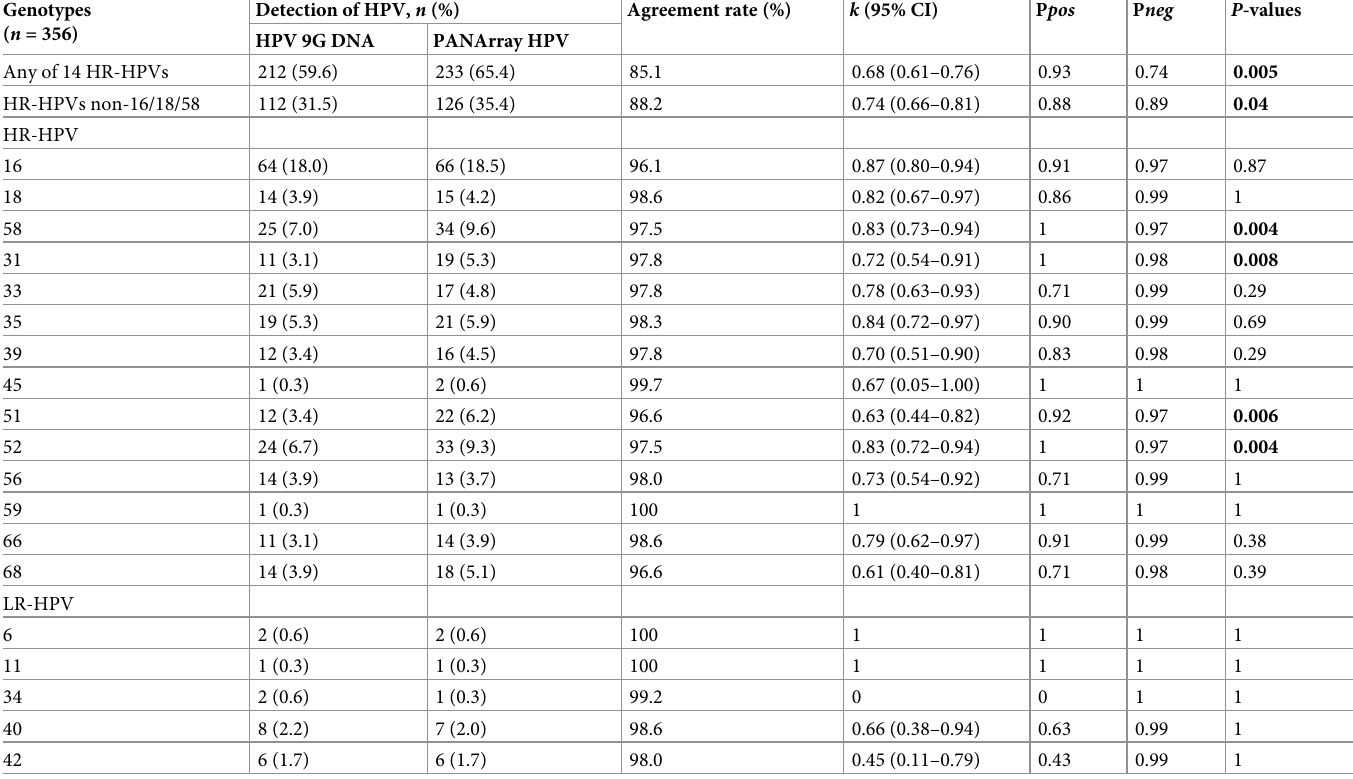
Table 2. Type specific agreement for each HPV type detected by HPV chip